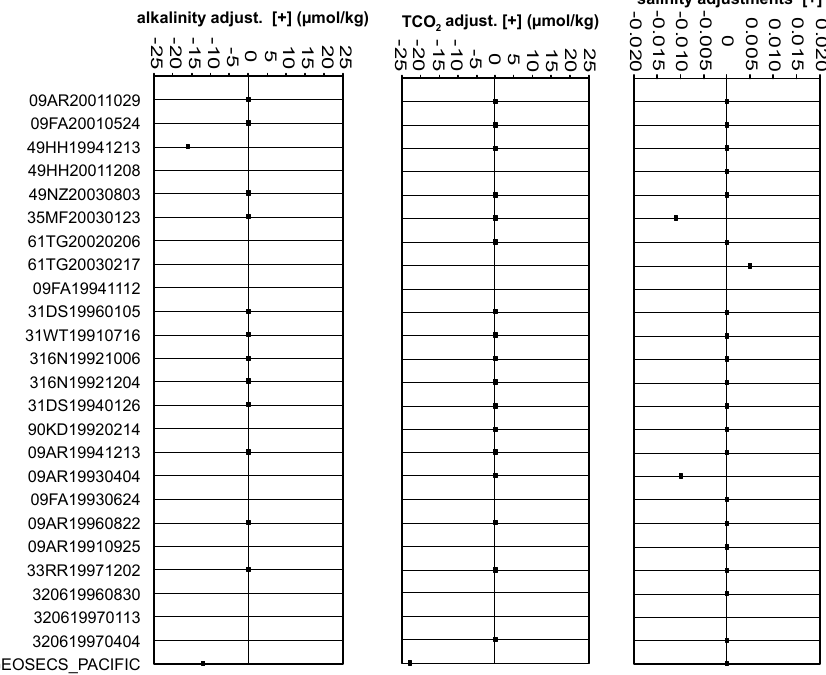
Figure 5. Additive adjustments made to alkalinity, TCO 2 and salinity data.